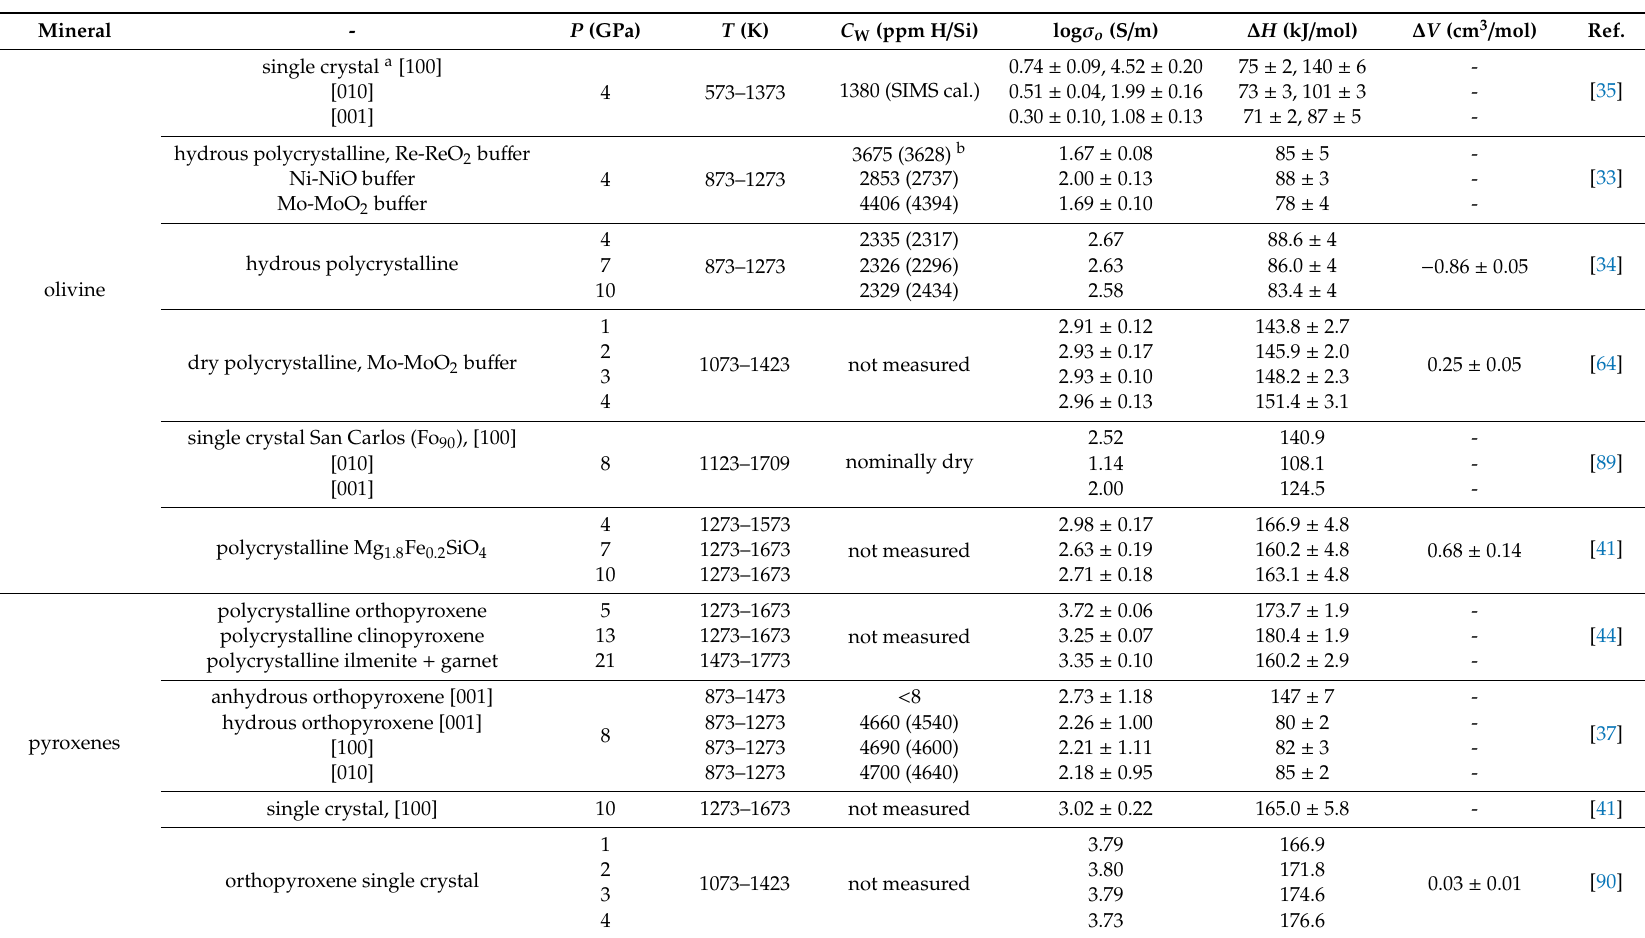
Table 1. Fitting parameters of the Arrhenius behavior of electrical conductivity ( σ = σ · exp ( − ∆ H / RT ) ) of the major minerals in the upper mantle and transition zone, at di ff erent P-T conditions, measured exclusively by the impedance spectroscopy technique. The pre-exponential term σ o , may include the contribution of water content C w and oxygen fugacity, where